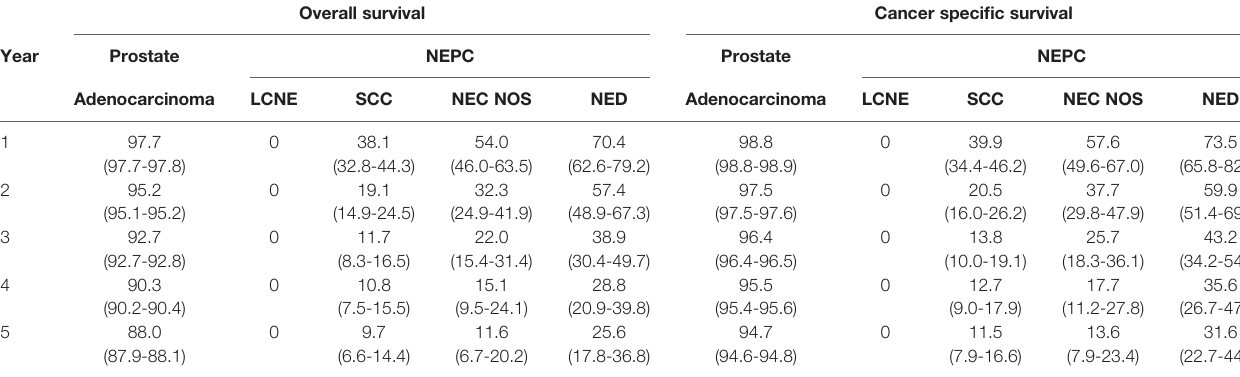
TABLE 3 | Overall survival and cancer speci fi c survival of patients with NEPC and prostate adenocarcinoma. Overall